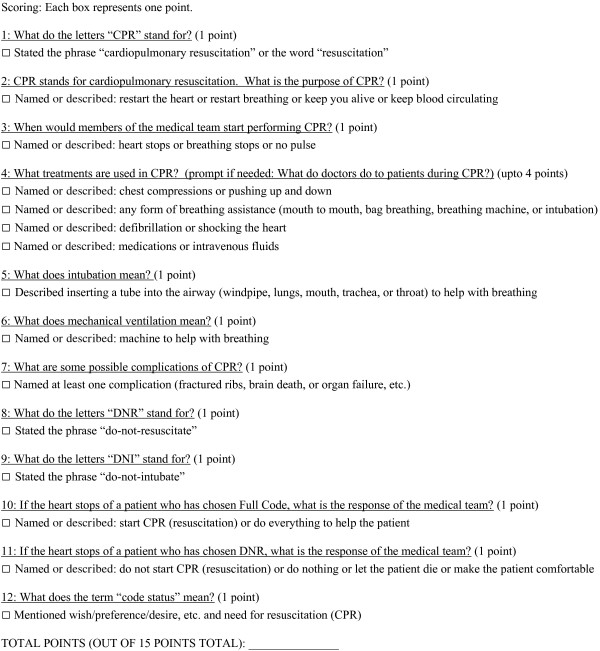
CPR survey instrument (with criteria for receiving credit for a given response).